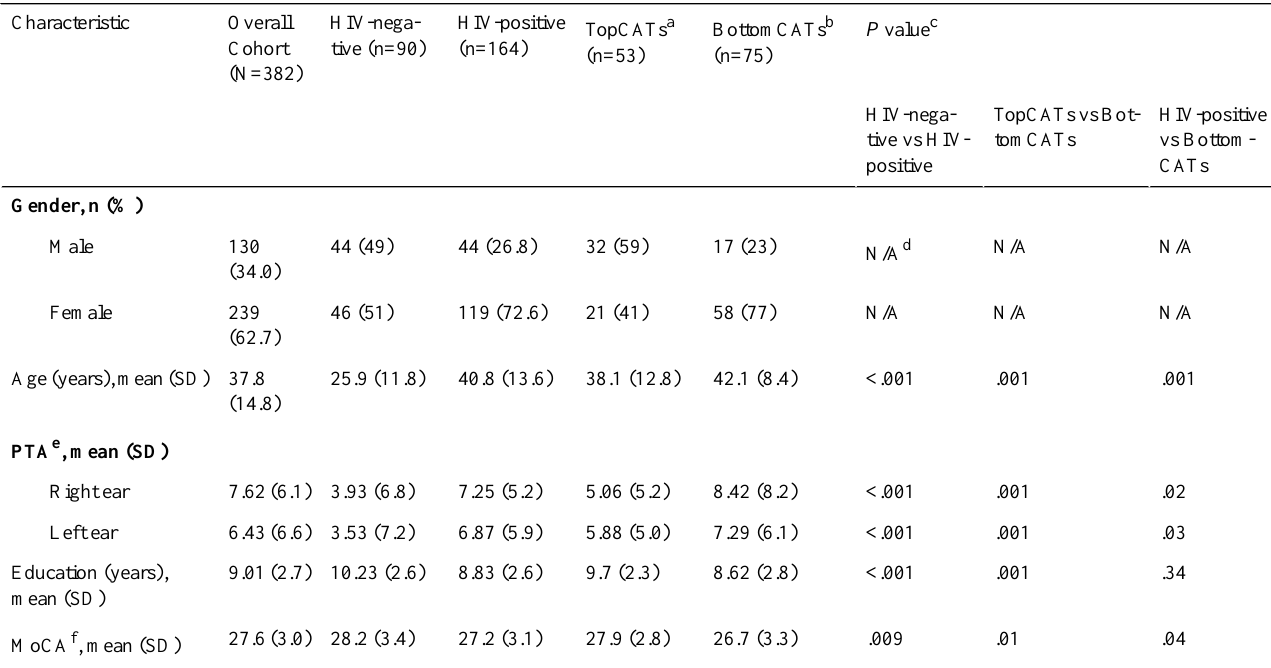
Table 1. Demographic information.